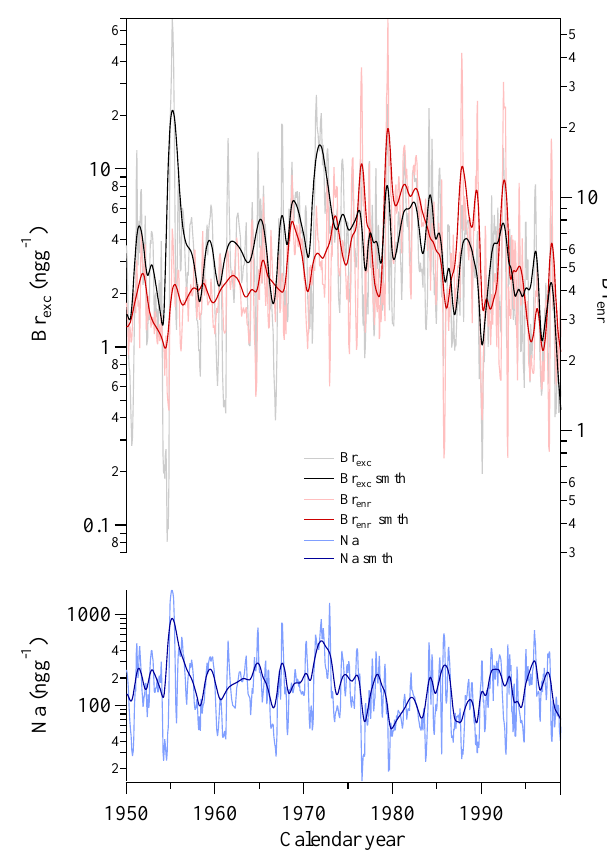
Figure 6. Comparison between bromine excess (Br exc ) concentra- tions, bromine enrichment (Br enr ) ratios and sodium (ngg − 1 ) from the Akademii Nauk ice core. Raw (grey line) and 3-year smoothed (black line) Br exc concentrations and raw (pink line) and 3-year smoothed (red line) Br enr are shown on logarithmic scales. Raw (light blue) and 3-year smoothed (dark blue) sodium data are also